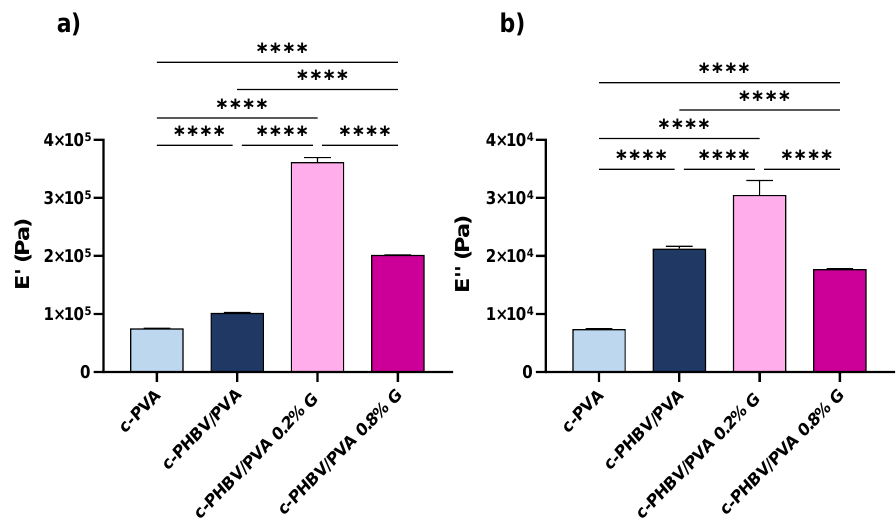
Figure 8. Dynamical mechanical analysis (compression mode). ( a ) Storage modulus ( E ′) and ( b ) loss modulus ( E ″) at 37 °C for c-PHBV/PVA and nanohybrid hydrogels with 0.2% and 0.8% of G nanosheets. Crosslinked PVA (c-PVA) is included as reference. Graph shows mean ± standard deviation; (****) indicates significant differences ( p < 0.001).